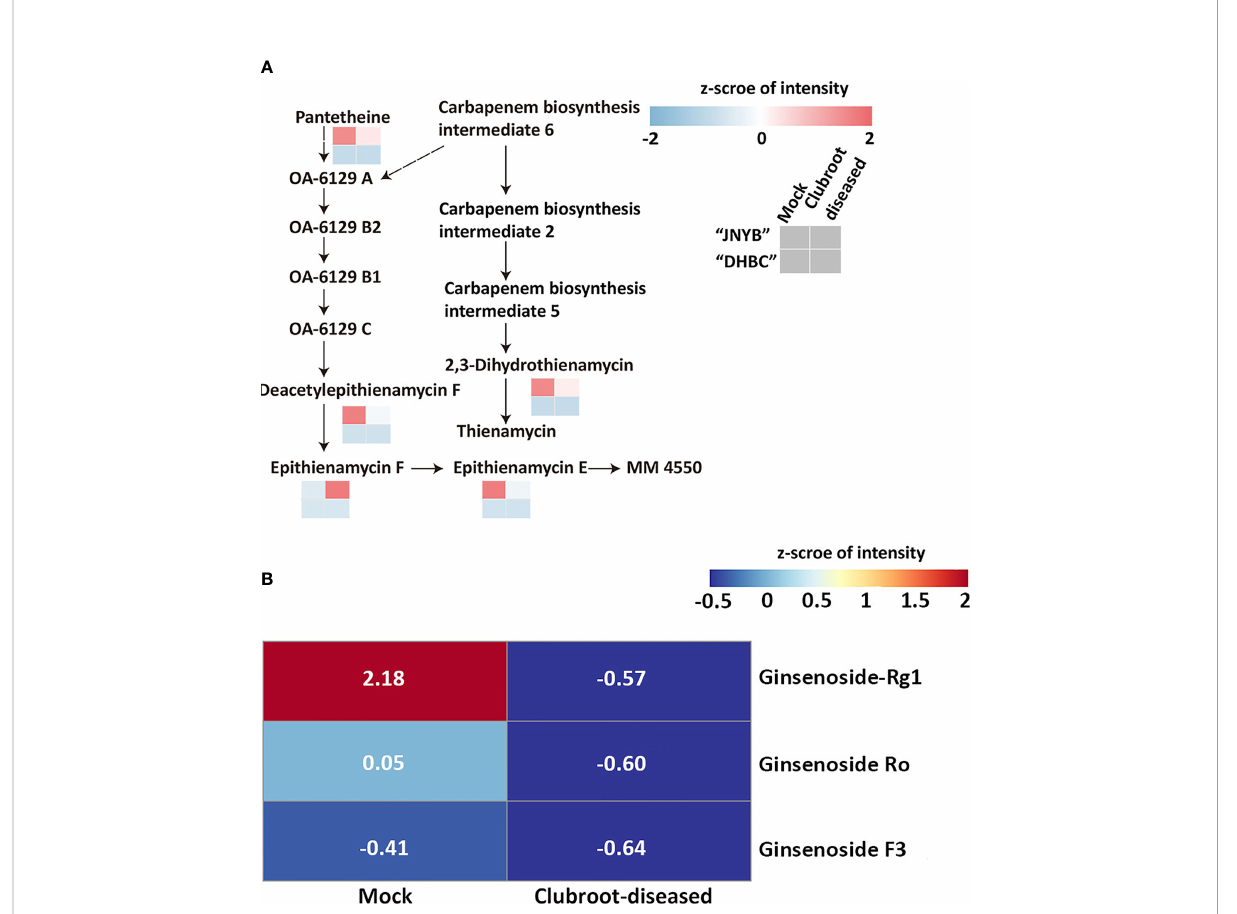
FIGURE 5 Analysis of carbapenem pathway (A) and ginsenoside metabolism (B) affected by P. brassicae infection. Data were normalization